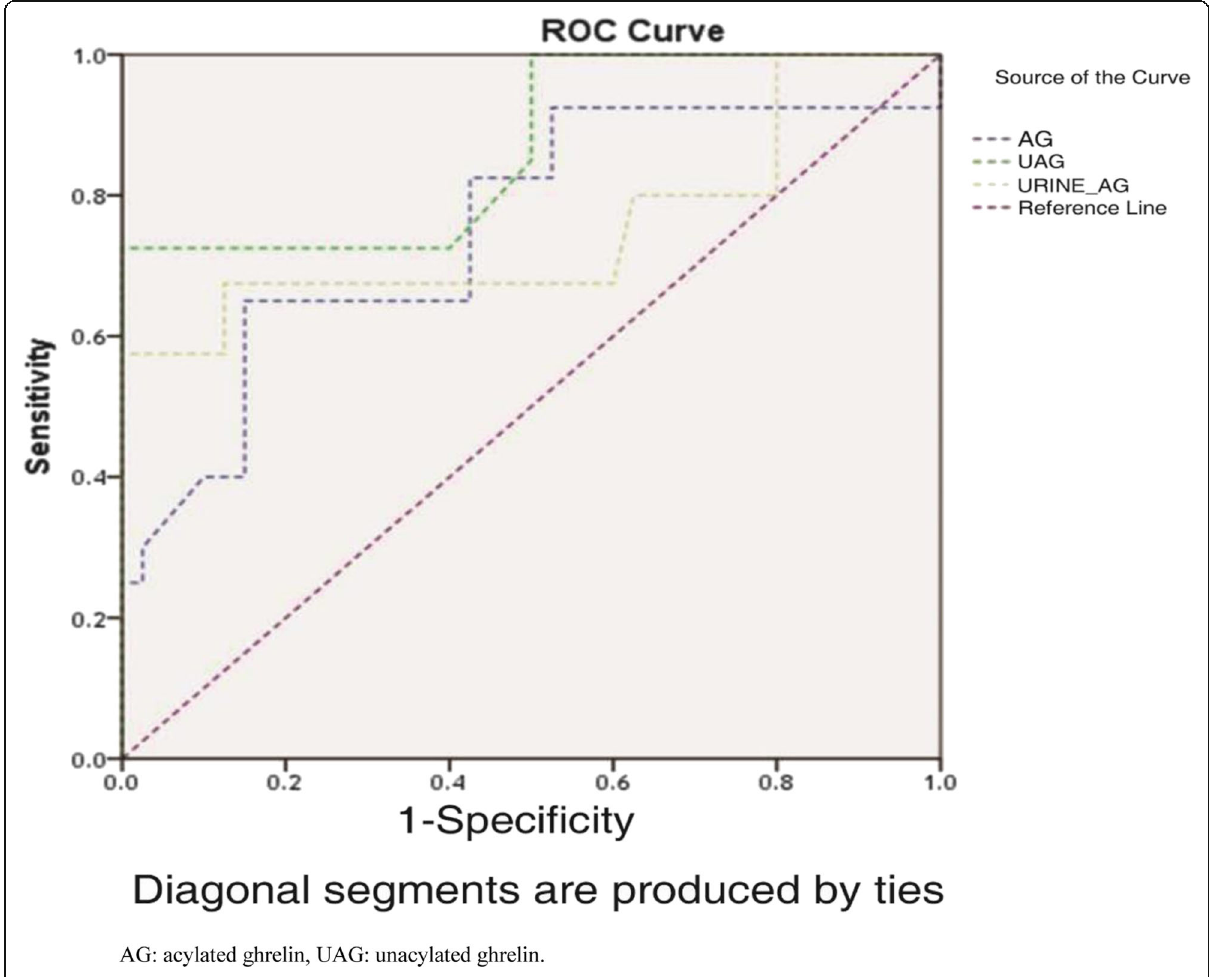
Fig. 1 Sensitivity and specificity of serum acylated ghrelin, unacylated ghrelin, and urine ghrelin in detection of cutoff levels of the patients